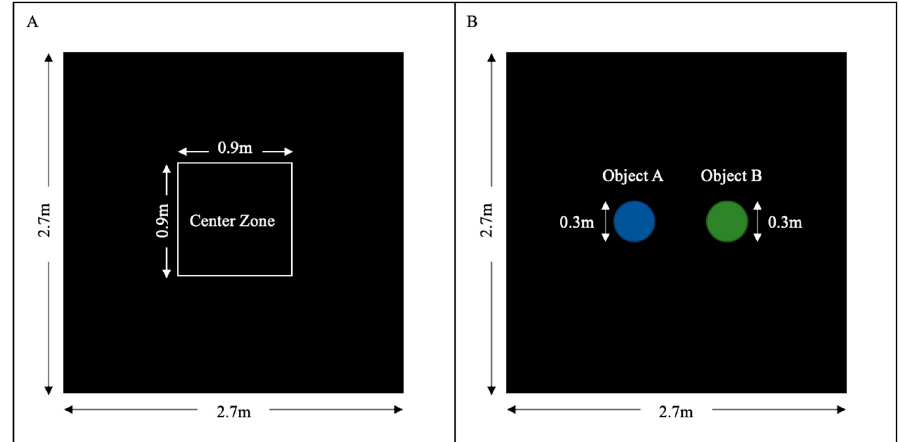
Figure 2. Schematic illustration of the testing arena for open field test (A) and the object recognition test (B).